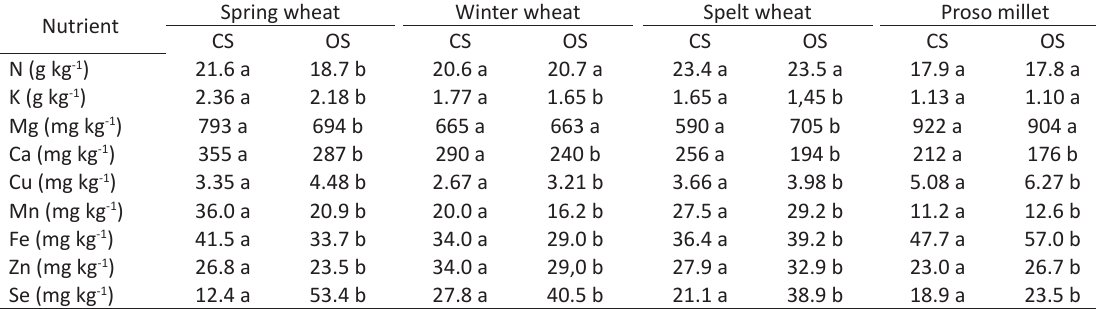
Table 6. Content of some macro- and micronutrients in cereal grain; mean for 2011-2013 Spring Nutrient